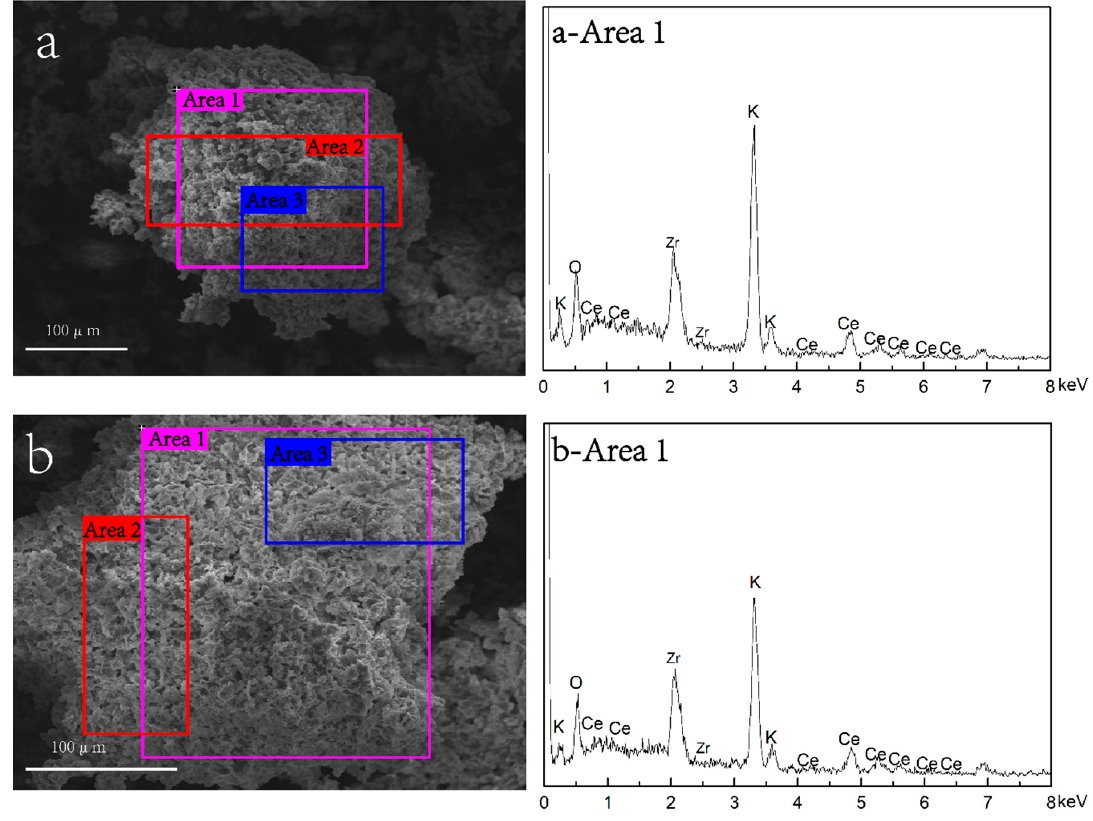
Figure 6. SEM and EDS of catalyst K / ZC after ( a ) second catalytic cycle, (a-Area 1) EDS of second catalytic cycle in Area 1, ( b ) five catalytic cycle, (b-Area 1) EDS of five catalytic cycle in Area 1.